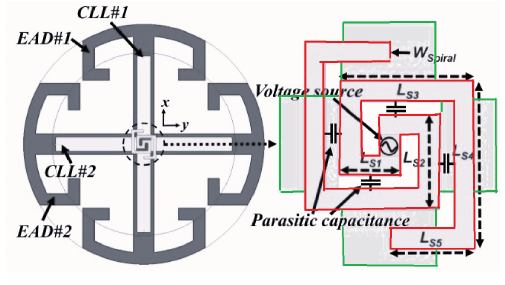
Figure 11. A WPT system with Huygens circularly polarized antenna, driven spiral line structure with capacitively loaded loop and Egyptian axe dipole.